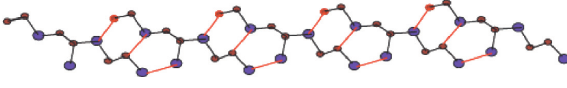
Figure 7: Sheet of Si